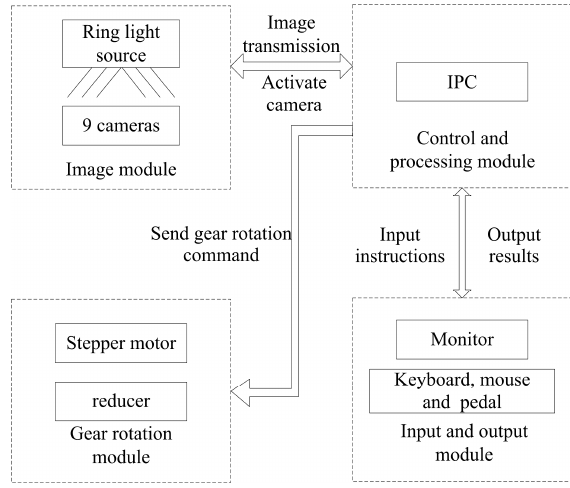
Figure 5. Hardware structure of the bevel gear inspection system.